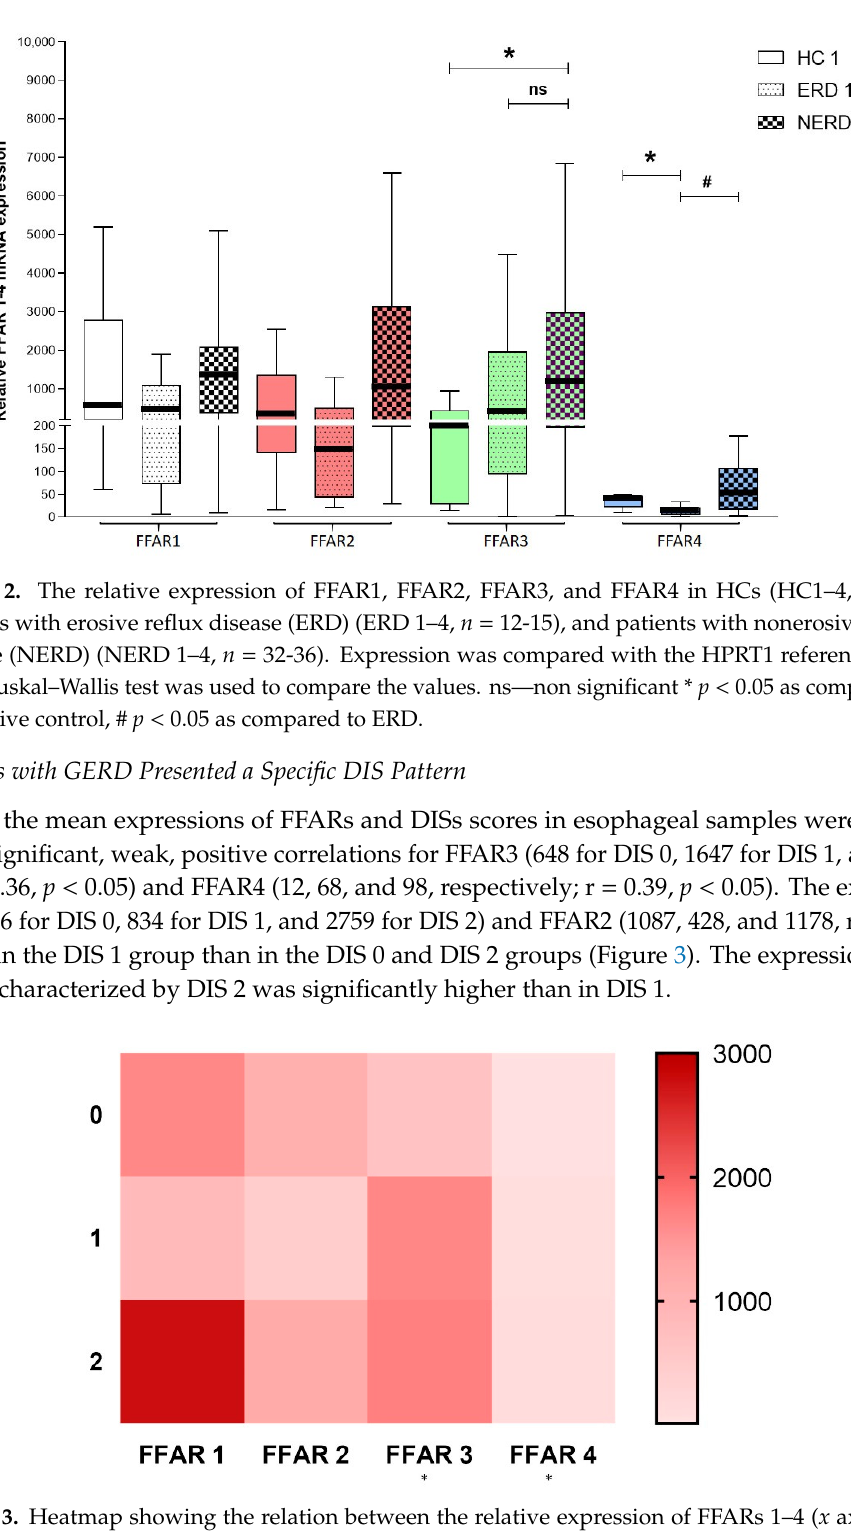
Figure 3. Heatmap showing the relation between the relative expression of FFARs 1–4 ( x axis) and DIS score ( y axis) ( n = 24–30). Heat legend is located on the right side of graph. Calculated using the Spearman rank correlation test, * p < 0.05.